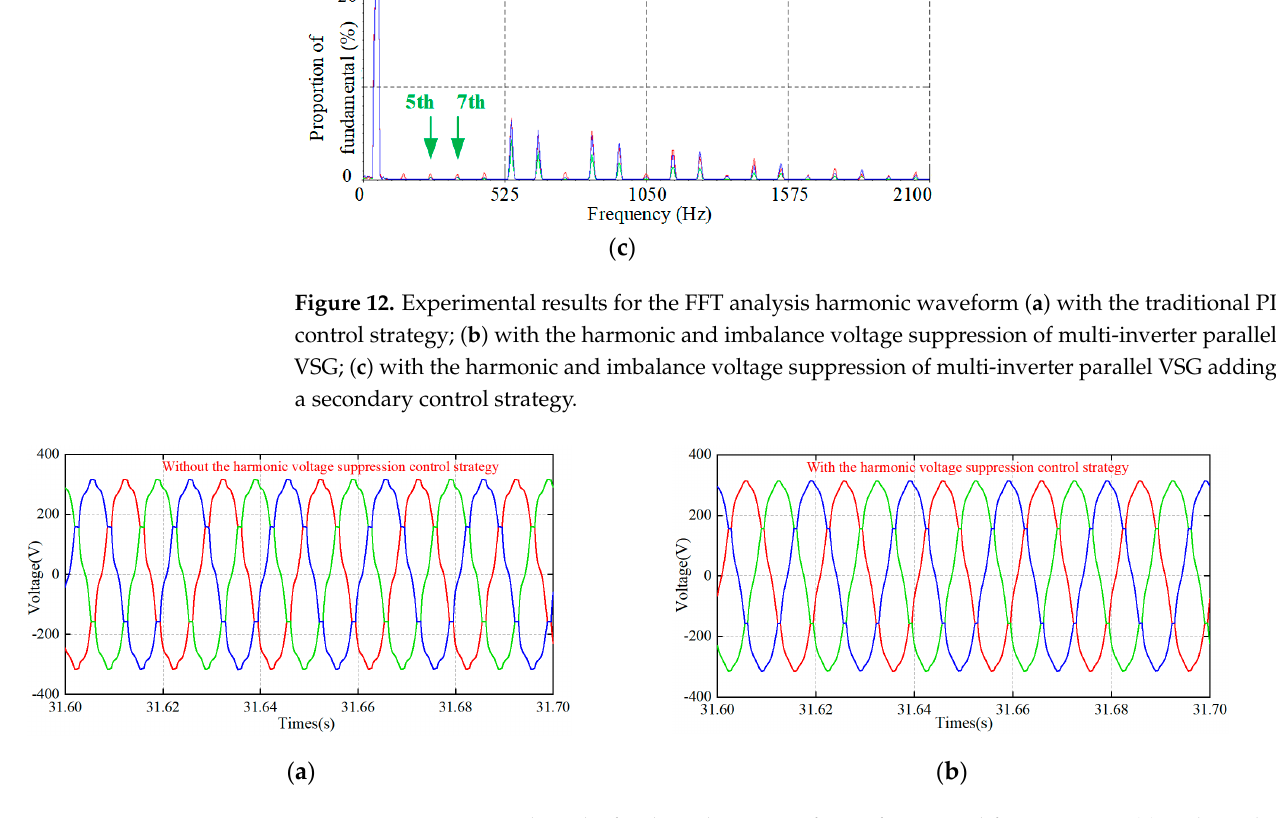
( c ) Figure 14. Experimental results for the frequency waveform ( a ) with the traditional PI control strat- egy; ( b ) with the harmonic and imbalance voltage suppression of multi-inverter parallel VSG; ( c ) with the harmonic and imbalance voltage suppression of multi-inverter parallel VSG adding a sec- ondary control strategy. As shown in Figure 15a,b, similar to system frequency control, when the system power fluctuates, the system voltage amplitude will also produce different degrees of fluctuation. Furthermore, according to the inertia of the VSG, when the system power changes significantly, the voltage amplitude will also produce a significant deviation. In Figure 15c, by adding a secondary control strategy, the effective value of the PCC voltage can be stabilized at the rated 220 V, which meets the load power supply requirement, and the system stability voltage control effect is enhanced significantly.